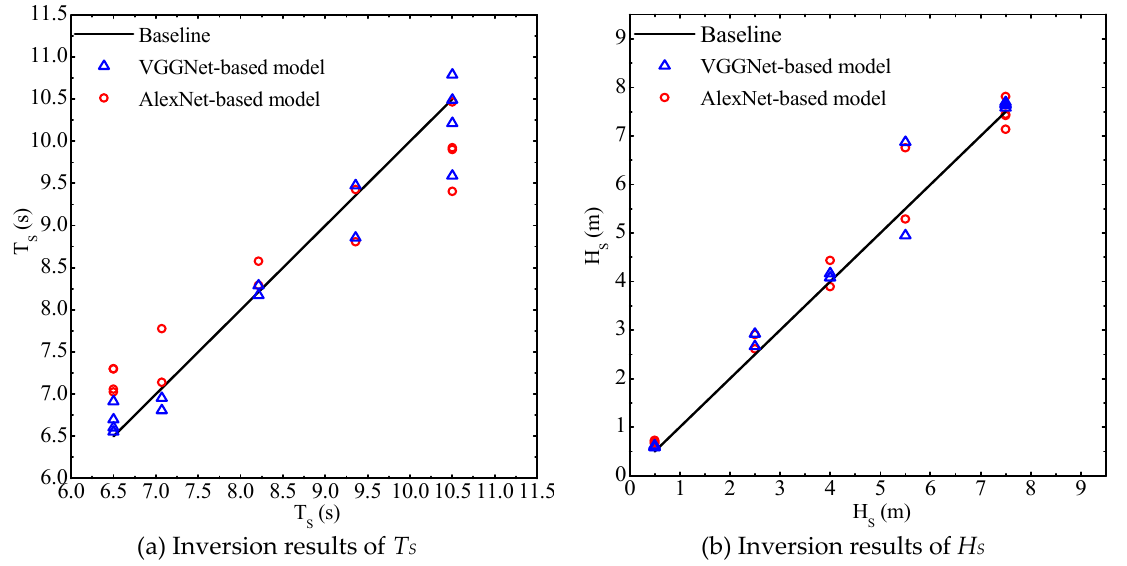
Figure 9. The range of parameter settings for the expanded training data set. H S means the significant wave height, and T S means the spectral peak period.